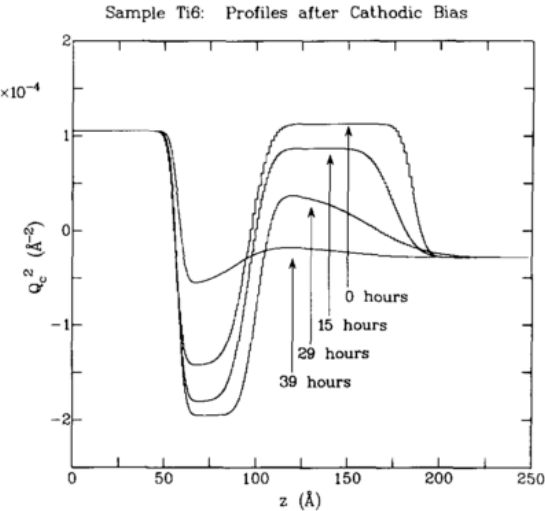
Figure 7. SLD profiles for a Ti film on Si under cathodic polarisation ( − 2 V) over time; the ingress of H is shown by the drop in SLD of the oxide layer and the increase in SLD of the metal (which has a more negative SLD than H). Reproduced with kind permission from [91], Elsevier, 1994.